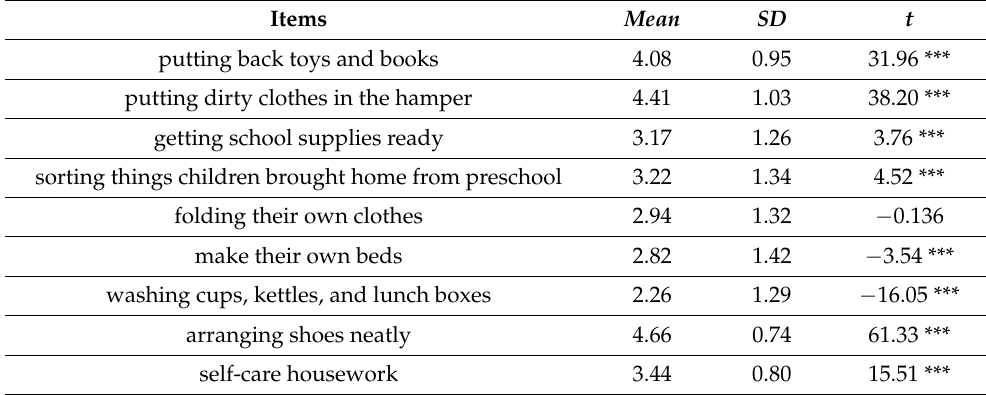
Table 1. Description of self-care housework (N = 775).